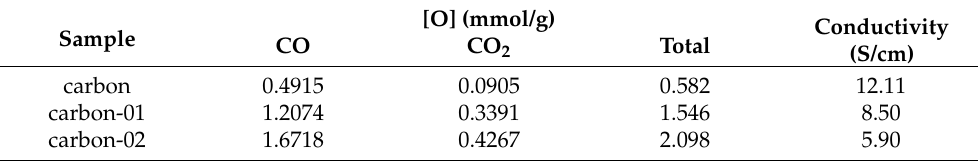
Table 3. Effect of H 2 O 2 treatment on the conductivity of the modified carbon